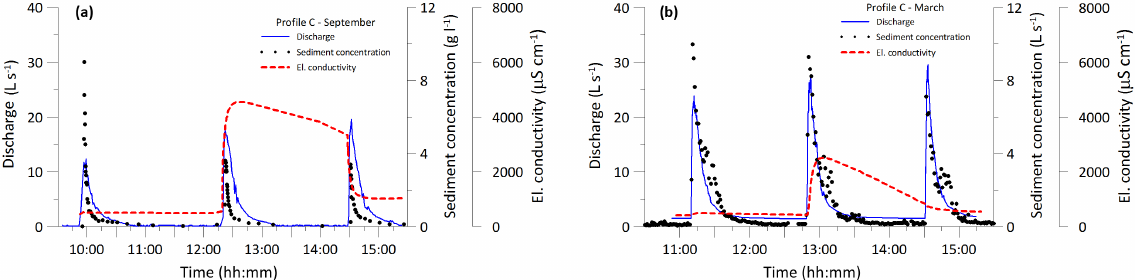
Figure 5. Measured outflow rates and the concentration of suspended solids in the Nuˇcice catchment outlet during experiments conducted in September 2012 (a) and in March 2013 (b) . The sediment mobility in September was limited by the lower peak discharge rates due to high vegetation density and dry initial